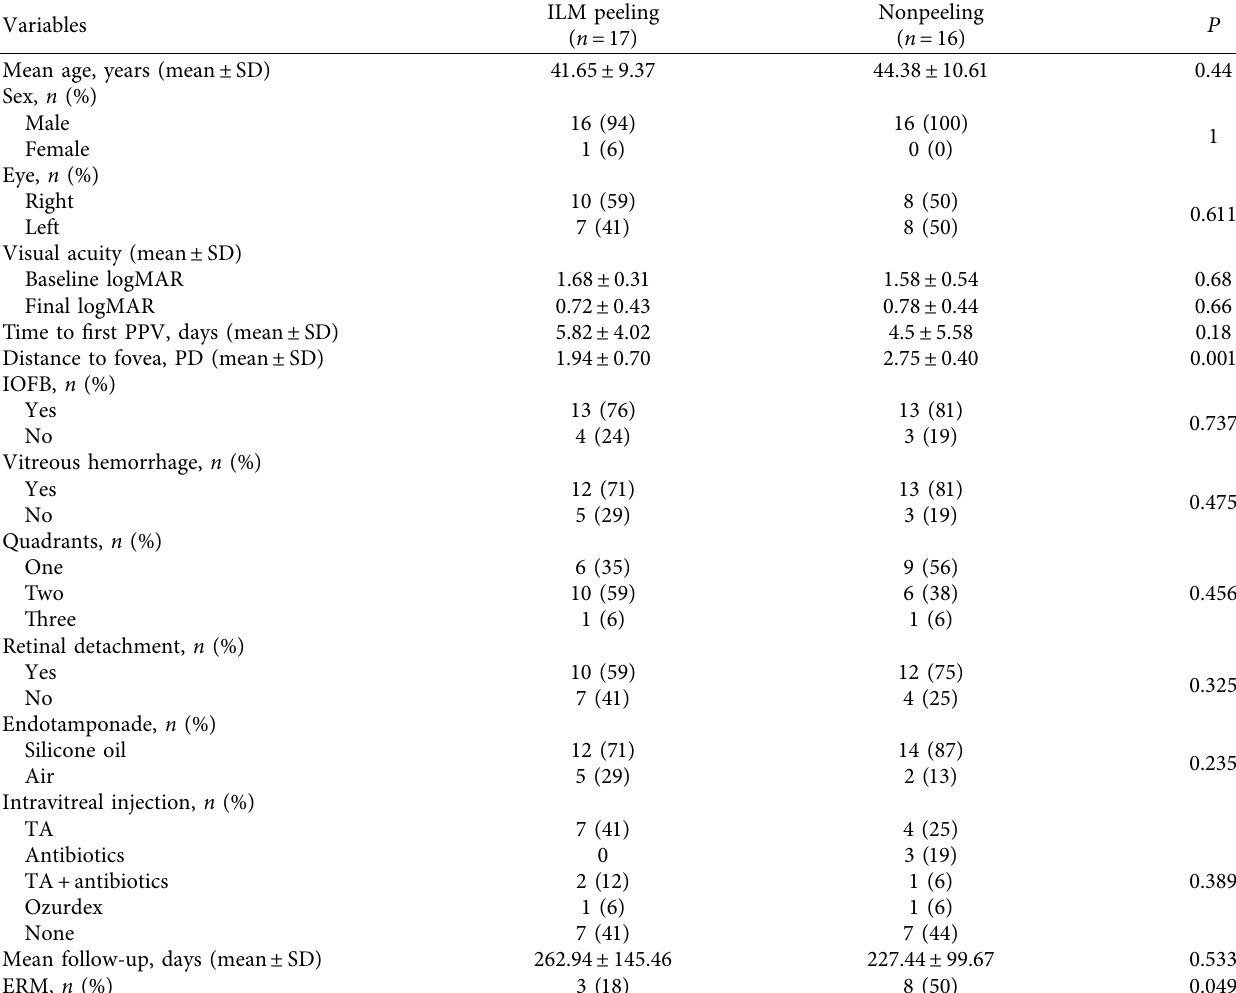
Table 1: Main characteristics of patients with or without ILM